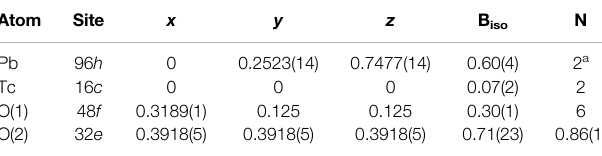
TABLE 1 | Re fi ned atomic coordinates and atomic displacement parameters for Pb 2 Tc 2 O 7-d . These parameters were obtained by re fi nement against a combined neutron and synchrotron X-ray diffraction data set. a (cid:1)